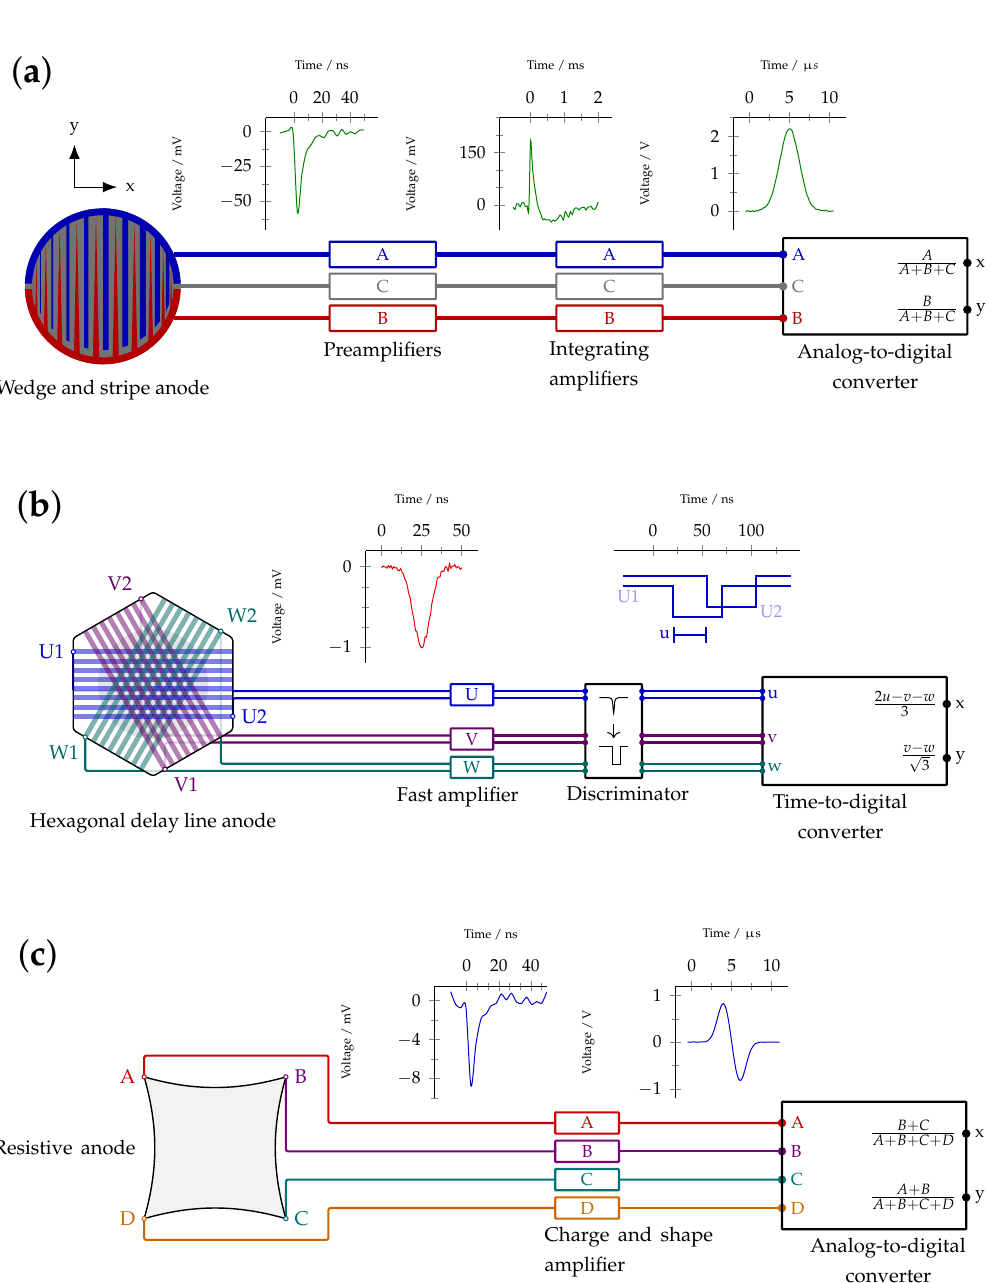
Figure 3. Operation principle and signal processing of the three used anode types. ( a ) wedge and strip anode: the position information is entailed in the amount of charge reaching the anode, i.e., the signal is processed through preamplifiers and integrating amplifiers and read out by an analog-to-digital converter (ADC). The shown coordinate system demonstrates the orientation of the x and y axis and is valid for all anode types. ( b ) delay line anode: the position is determined from signal delay times, the pulses are processed by fast amplifiers and read out by a time-to-digital converter (TDC); ( c ) resistive anode: the position is determined from signal heights at four anode edges at 45 ◦ with respect to the coordinate axes. Here, the signals are processed through amplifiers and a position computer and read out by an